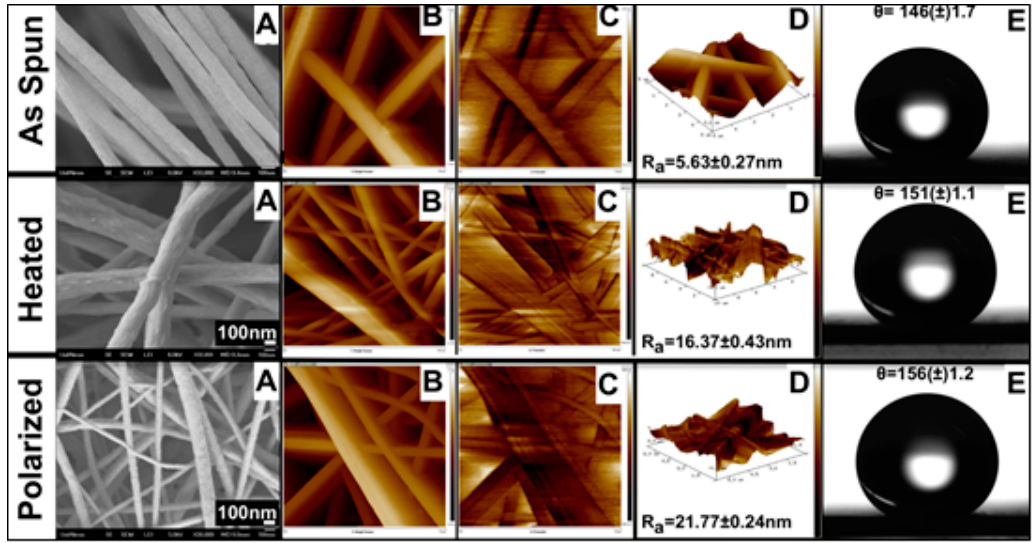
Figure 9. SEM ( A ), AFM ( B , C , D ), and DSA ( E ) characterizations of electrospun PVDF fibers.